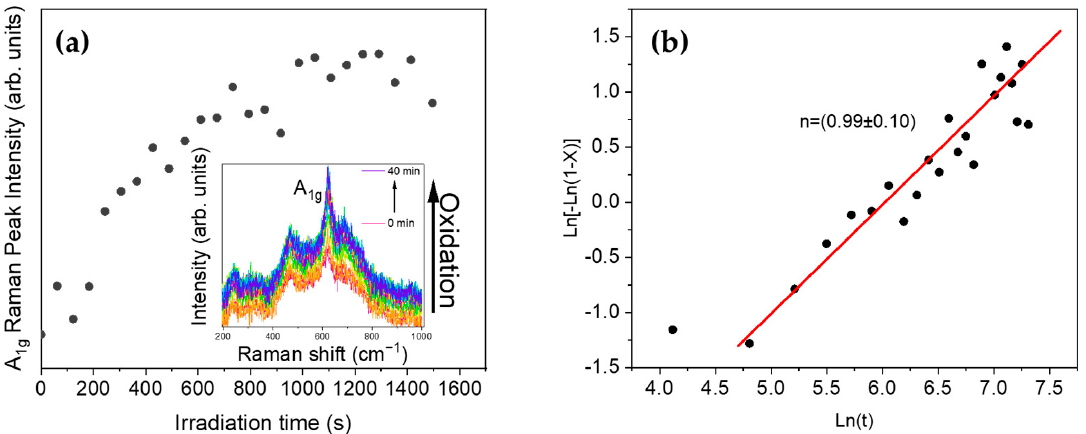
Figure 4. ( a ) Evolution of the A 1g Raman peak corresponding to SnO 2 with increasing irradiation time, using the UV laser and the D03 filter (0.5 · I 0 ). Inset in ( a ) shows the spectra acquired using UV laser irradiation from 0 to 40 min. ( b ) Avrami plot from the data presented in ( a ).